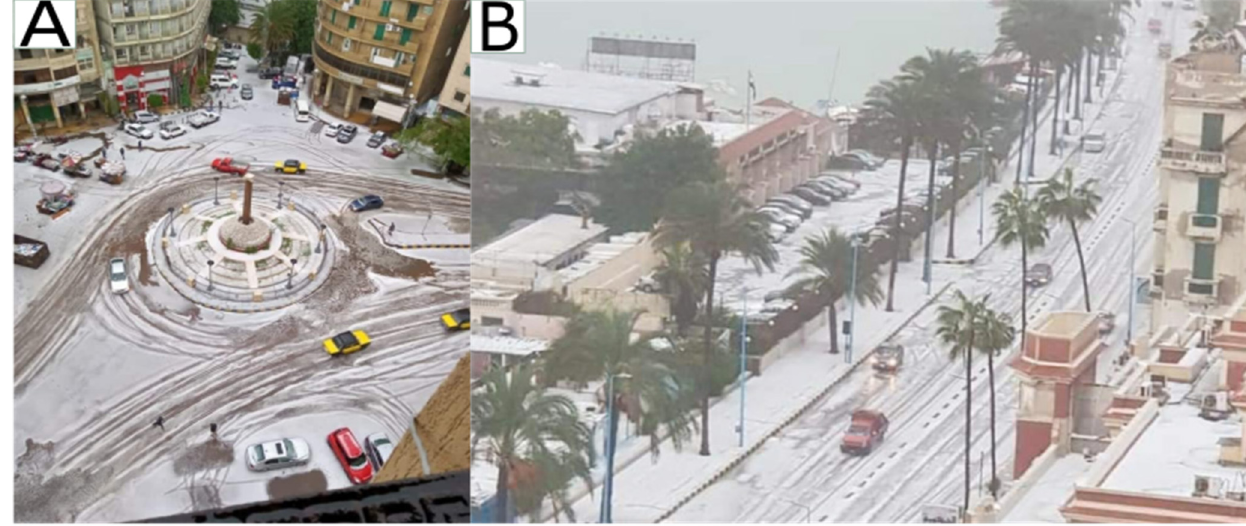
Figure 10. ( A , B ) Rare snow falls over Alexandria in December